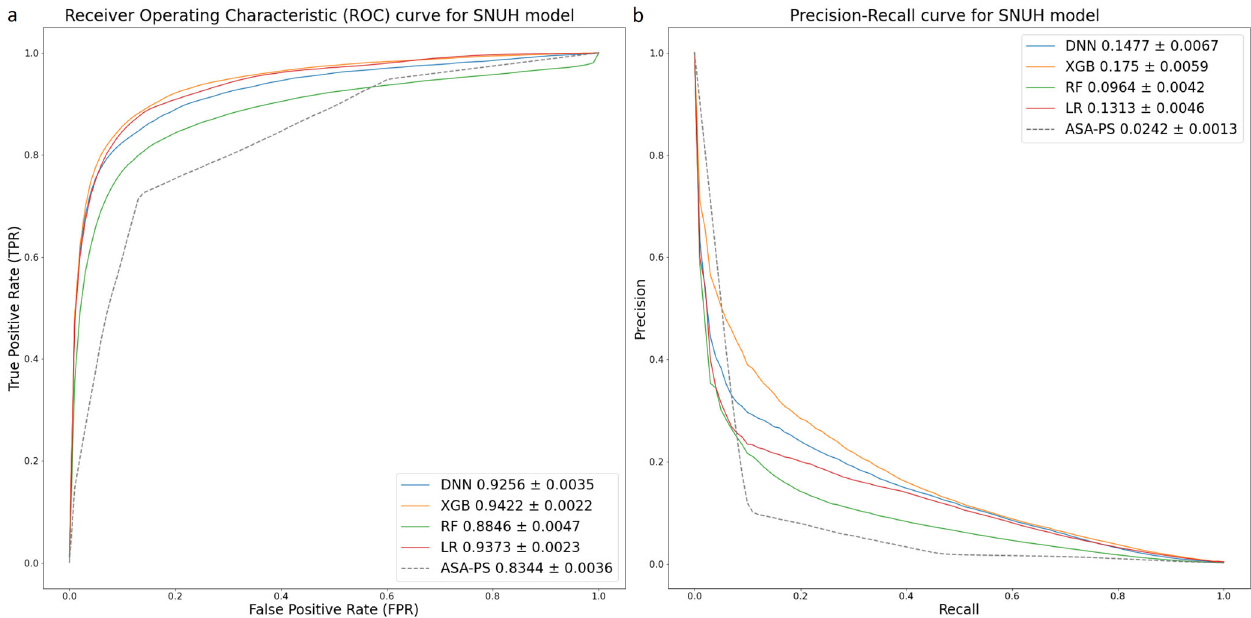
Fig. 1 Performance evaluation of machine learning algorithms for postoperative 30-day mortality predictions. AUROC ( a ) and AUPRC ( b ) of several models for postoperative 30-day mortality in the SNUH dataset. The values of AUROC and AUPRC are presented as 95% con fi dence intervals. AUROC area under receiver operating characteristic curve, AUPRC area under precision-recall curve, DNN deep neural network, XGB extreme gradient boosting, RF random forest, LR logistic regression, ASA-PS American society of anesthesiologists physical status classi fi cation.